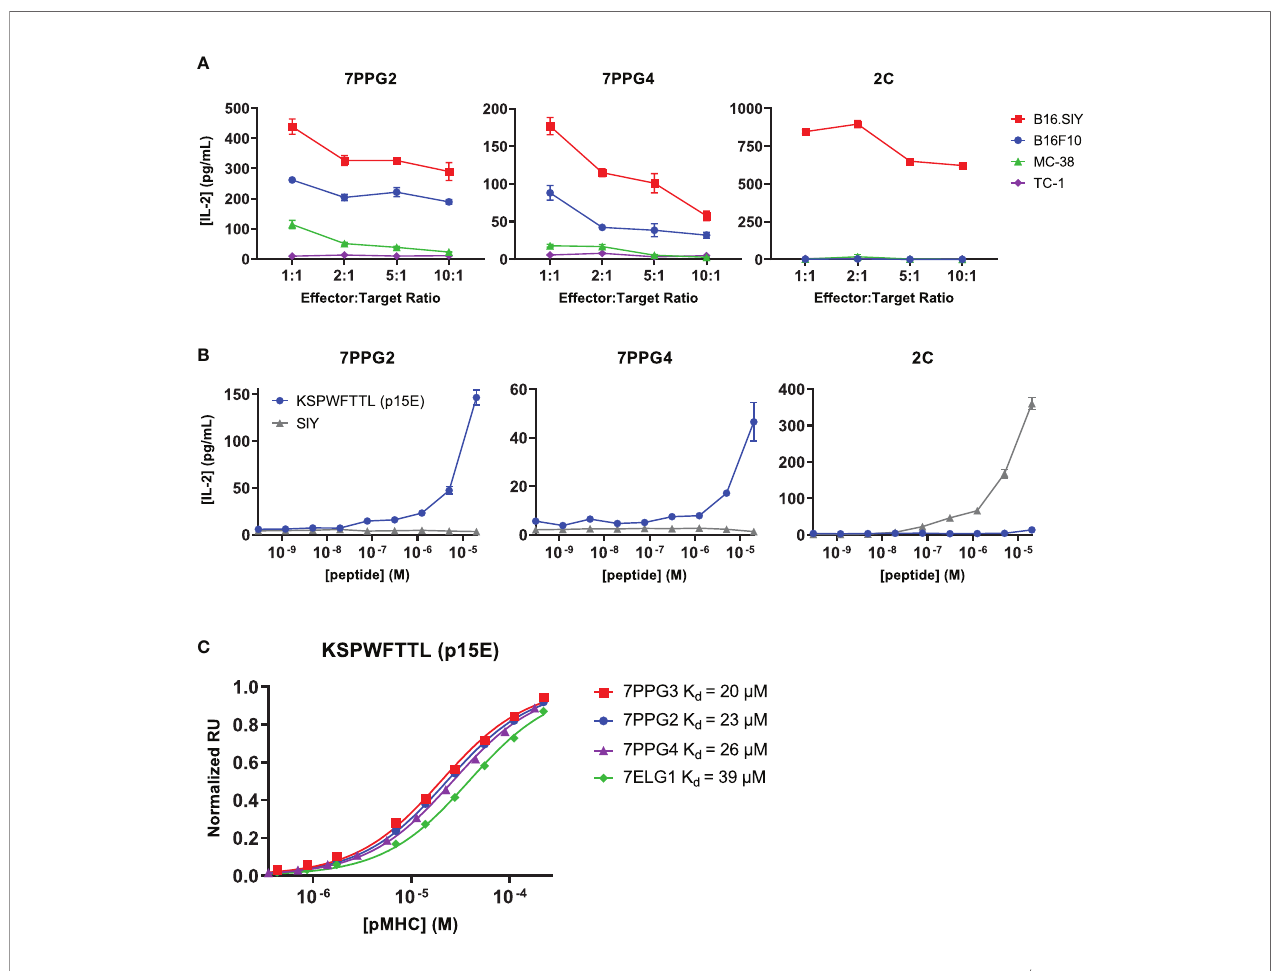
FIGURE 2 | TCR-transduced T cells are activated by an endogenous retrovirus peptide expressed by multiple tumor types. (A, B) 58 -/- cells transduced to express the 7PPG2, 7PPG4, and 2C TCRs were cocultured with B16F10, B16.SIY, MC-38, and TC-1 cancer cell lines at various effector:target ratios (A) or with DC2.4 cells loaded with p15E or SIY peptide (B) . T cell activation was assessed by IL-2 ELISA. Data shown are mean+s.e.m. of triplicate (A) or duplicate (B) samples and are representative of 3 independent experiments. (C) Surface plasmon resonance was performed to quantify af fi nities between four TCRs and KSPWFTTL peptide presented by H-2K b